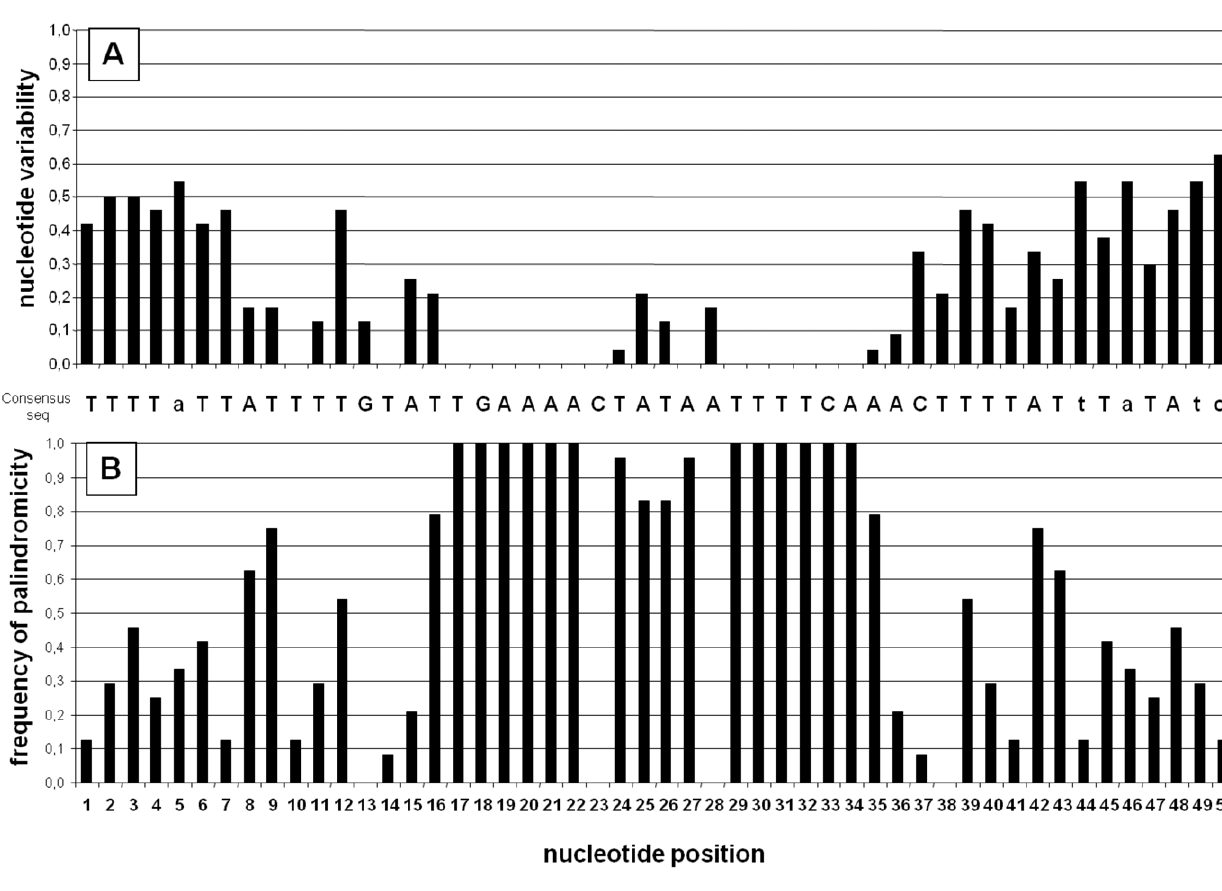
Figure 3. difH sequences. (A) difH consensus sequence and nucleotide variability for difH sequences from 24 epsilon- proteobacterial species (Table 2). If a given nucleotide is present in more than 50% of species it is written in upper case; if not, the most frequent nucleotide is in lower case. The nucleotide variability at each position was defined as 1–f, where f is the frequency of the most frequent nucleotide. (B) Palindromicity was analysed by comparing the 50-nt difH sequence with its inverted complementary counterpart in the 24 epsilon-proteobacterial species (Table 2). When a nucleotide was found both in difH and in the reverse complementary sequence, a value of 1 was given to the position. Next, the values for the 24 difH sequences for each position were added together to give the n value. The palindromicity frequency ( fpal ) was then estimated as: fpal = n / 24, with 24 being the number of difH sequences analysed. A fpal value of 1 given to a nucleotide position means that the nucleotide is always part of a palindrome.